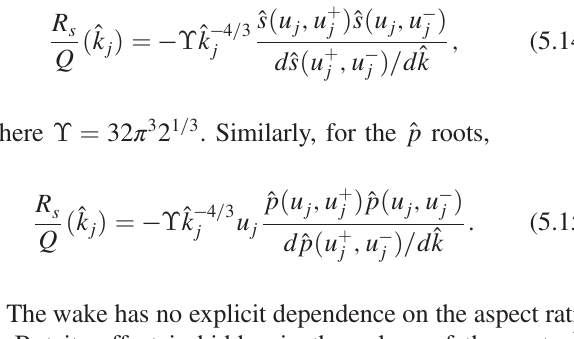
FIG. 3. A dimensionless R of the dimensionless wave number